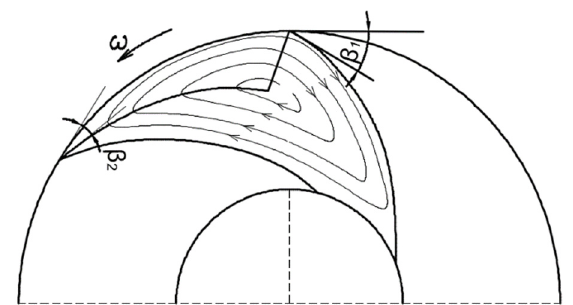
Figure 6. Turbine circumferential vortex diagram.